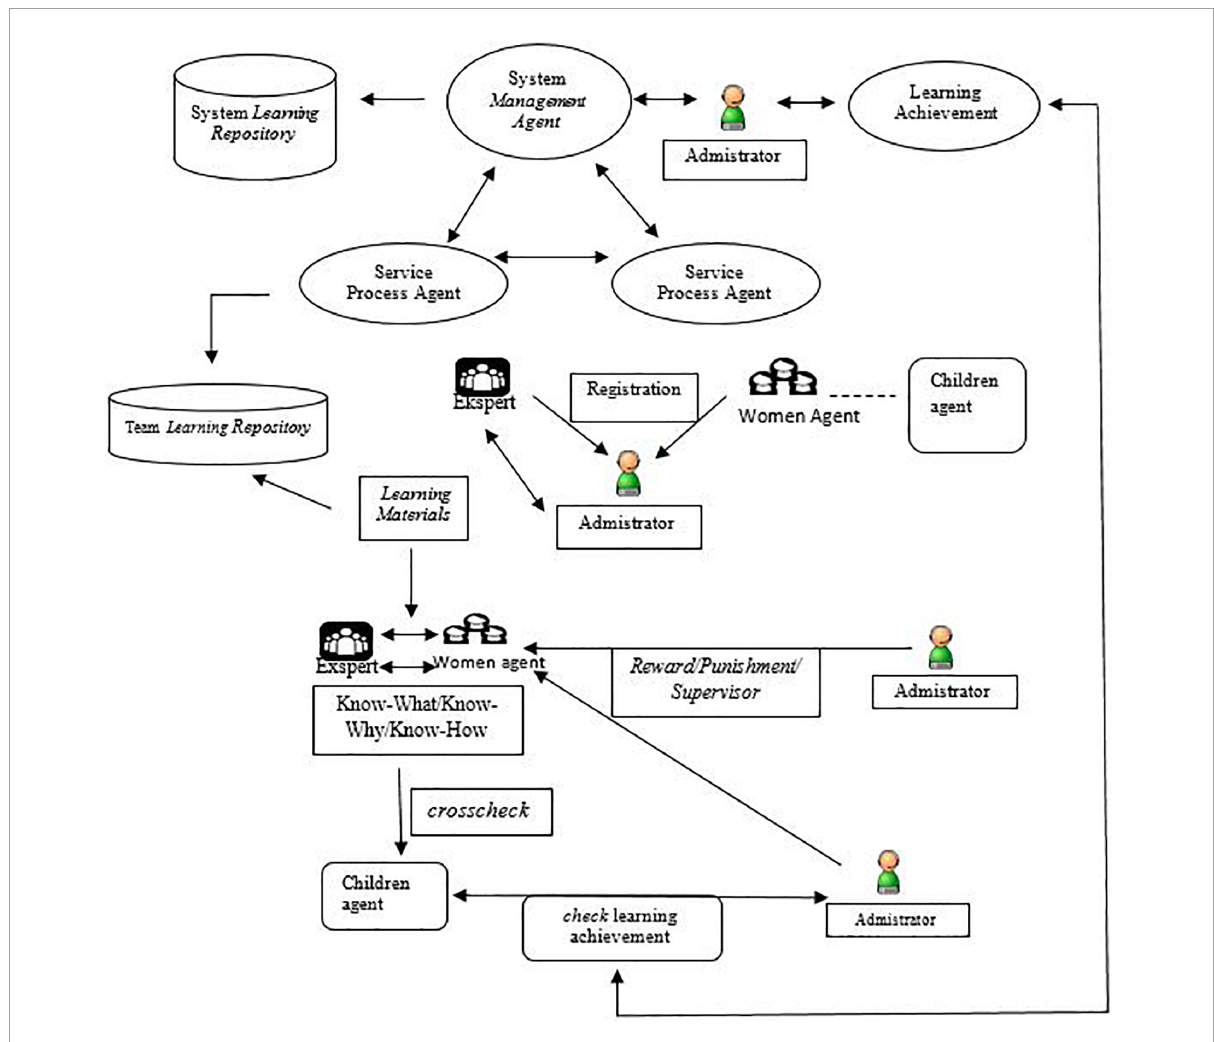
FIGURE1 Parties in the Butiko virtual